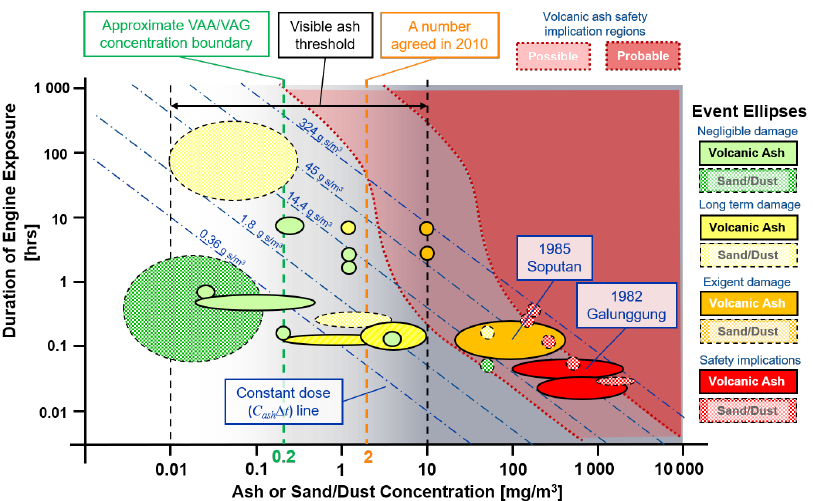
Figure 2. The Duration of Exposure versus Ash Concentration (DEvAC) chart, showing the two encounter events being investigated and their corresponding concentration and duration ranges